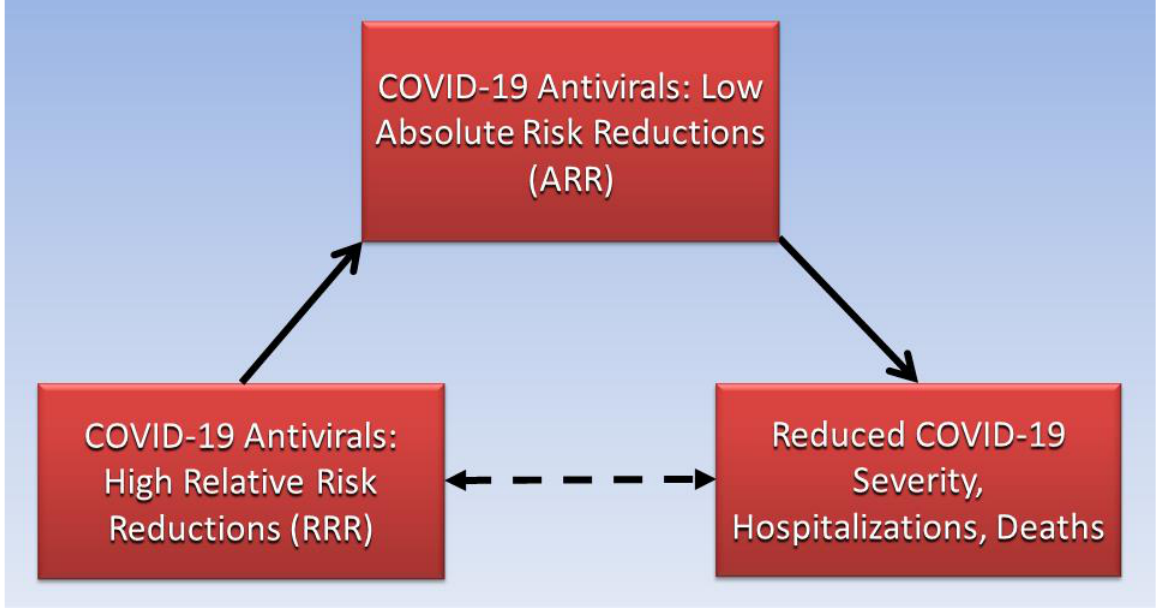
Figure 1. High RRRs of COVID-19 antivirals are mediated by low ARRs for severity, hospitaliza- tions, and deaths.